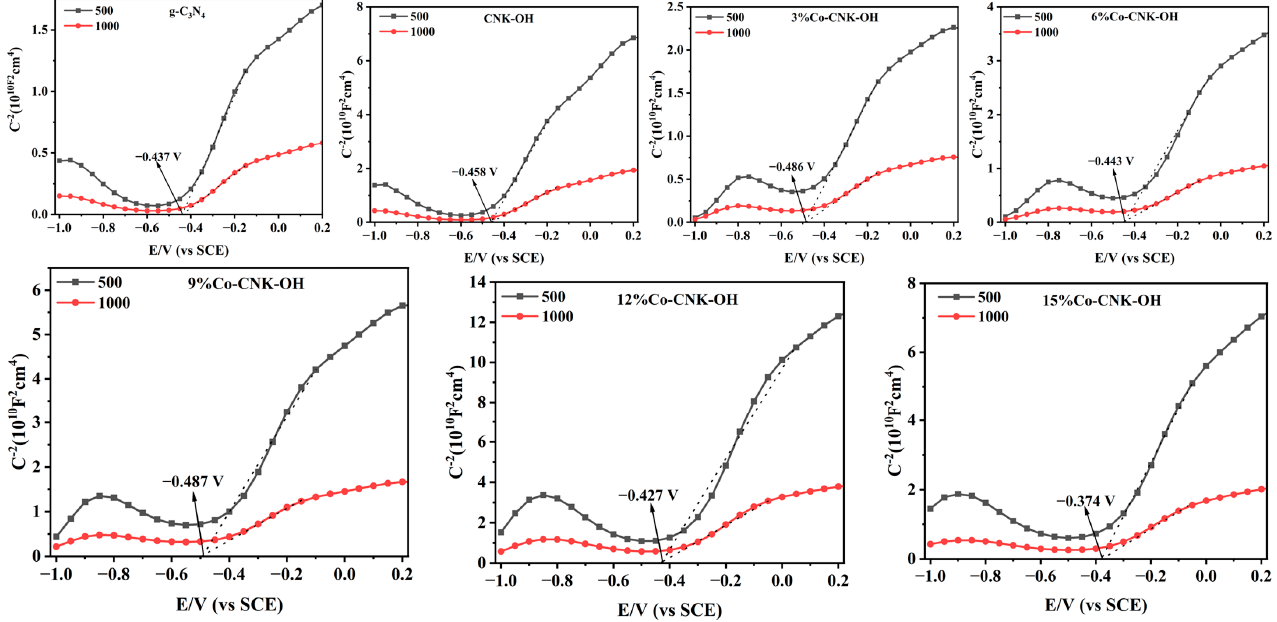
Figure 7. Mo tt –Scho tt ky curves of g-C 3 N 4 , CNK-OH, and Co-CNK-OH. Figure 7. Mott–Schottky curves of g-C 3 N 4 , CNK-OH, and Electrochemical impedance spectroscopy (EIS) is commonly used to probe the sepa- ration e ffi ciency of electrons and resistance to interfacial charge transfer of semiconductor materials. The EIS curves of g-C 3 N 4 , CNK-OH, and Co-CNK-OH are shown in Figure 8. The arc radius of 9%Co-CNK-OH was signi fi cantly smaller than those of the other sam- ples, implying that the electrical resistance of 9%Co-CNK-OH was the lowest, in accord- ance with the best electron-transfer performance and suggesting that Co 2+ modi fi cation signi fi cantly promote the interfacial charge to the electron acceptor and separate electrons and holes e ff ectively [43].